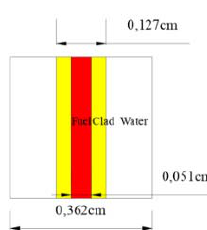
Figure 6. The geometry of one plate fuel pin cell problem